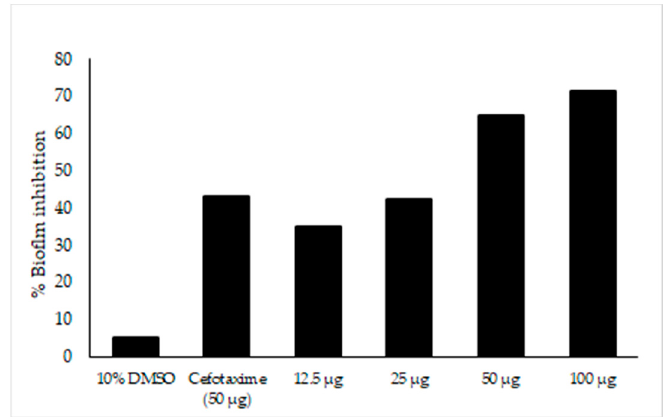
Figure 8. Effect of fungal crude extract Neocosmospora sp. MFLUCC 17-0253 on biofilm inhibition quantified by crystal violet. Biofilm formed in 96-well microtiter plate for 22 h was treated with different concentrations of fungal crude extract. The data represented by the mean of the results of a total of twelve readings.